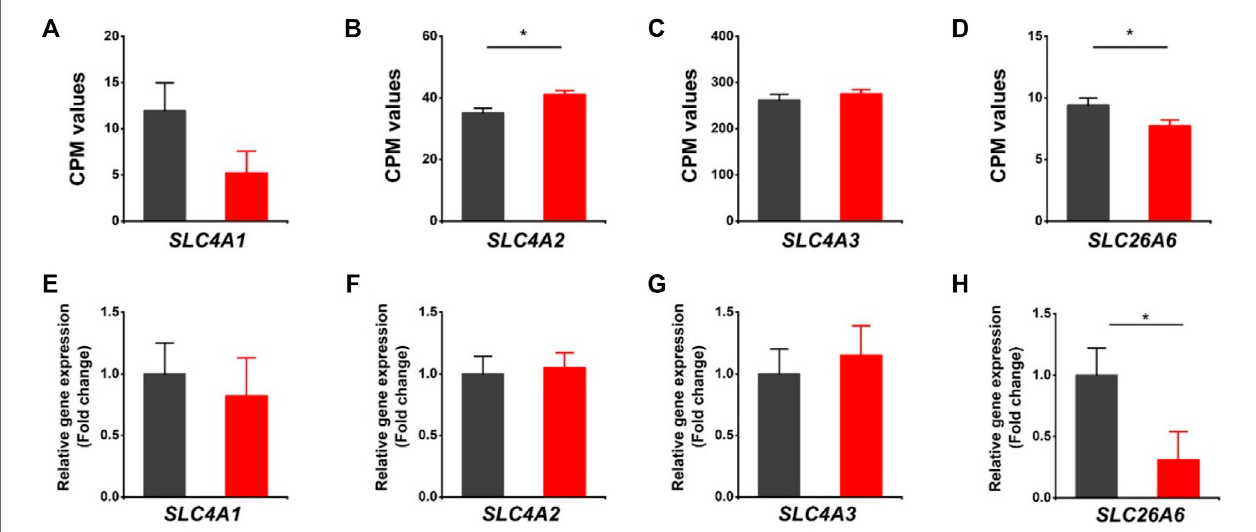
FIGURE 3 | Differentially expressed genes related to Cl − /HCO3 - exchangers in HVCN1 − / − hearts. Comparing relative gene expression levels of SLC4A1 (AE1), SLC4A2 (AE2), SLC4A3 (AE3), SLC26A6 between WT (black) and HVCN1 − / − (red) detected by RNA-seq (A-D) and qPCR (E-H) . n = 4 independent experiments for RNA-seq; n = 3 independent experiments for qPCR; * p < 0.05.